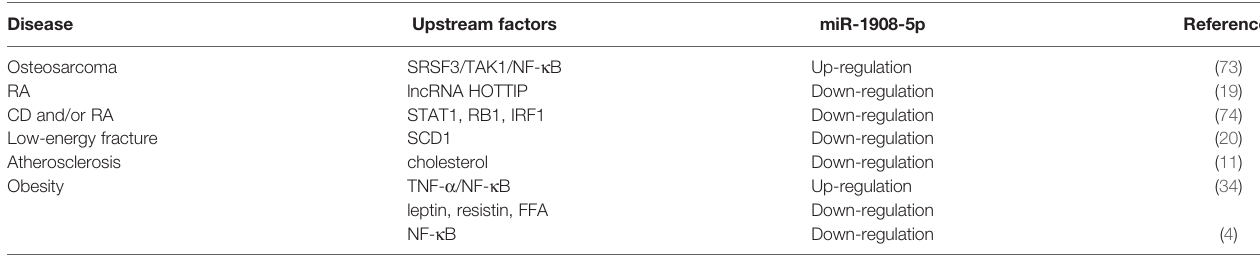
CD, Crohn ’ s disease; RA, rheumatoid